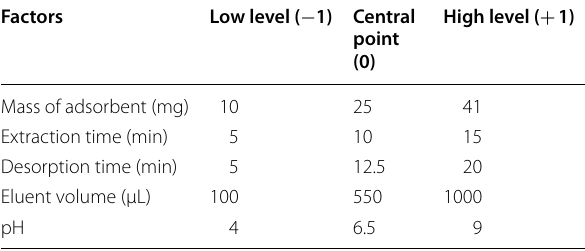
Table 1 Parameters and levels applied in CCD for d -MSPME